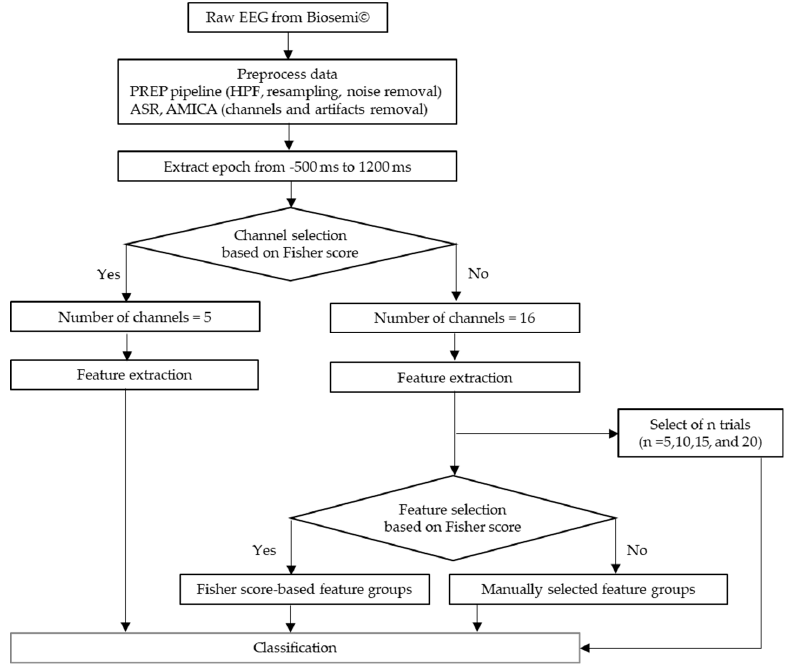
Figure 2. The flow of pain ‐ ERP processing.